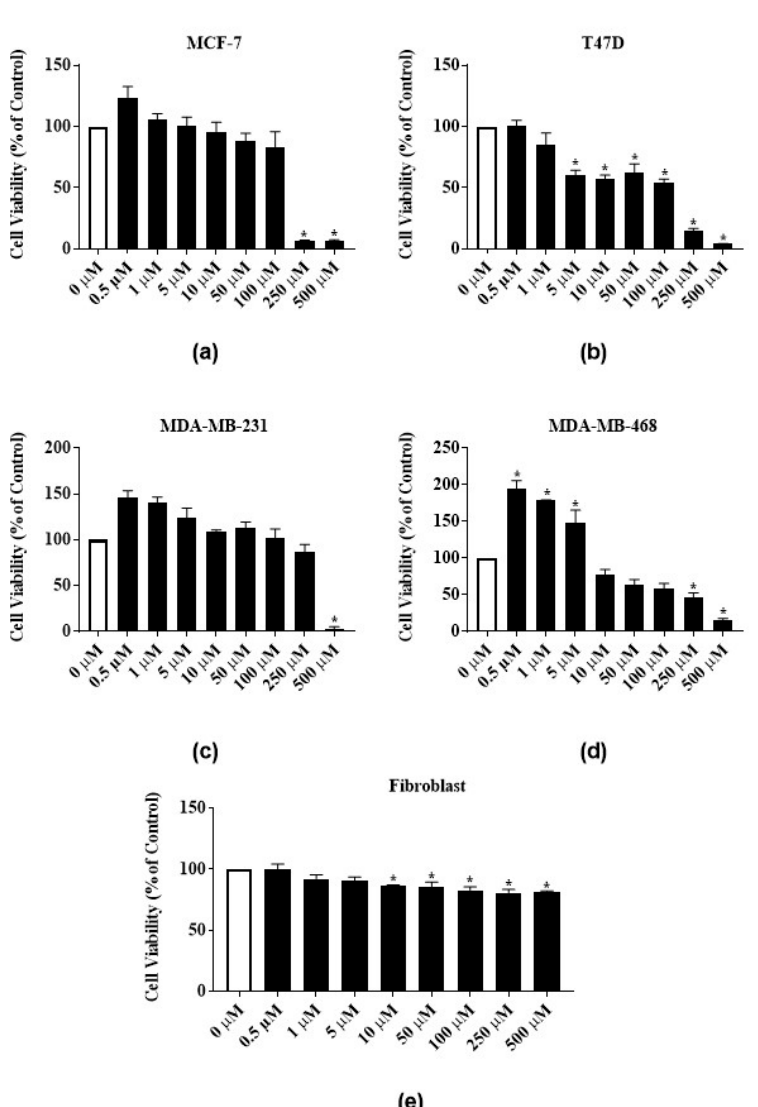
Figure 4. Antiproliferative activities of E . bicolor latex phytochemical RTX on ER-positive and triple negative breast cancer cell lines: ( a ) MCF-7 (ER+); ( b ) T47-D (ER+); ( c ) MDA-MB-231 (triple negative); ( d ) MDA-MB-468 (triple negative) breast cancer cell lines; and ( e ) effects of RTX on the growth of human normal primary dermal fibroblast. Bars with asterisks are significantly different from untreated control at p ≤ 0.05 (One-way ANOVA followed by Tukey’s posthoc test).